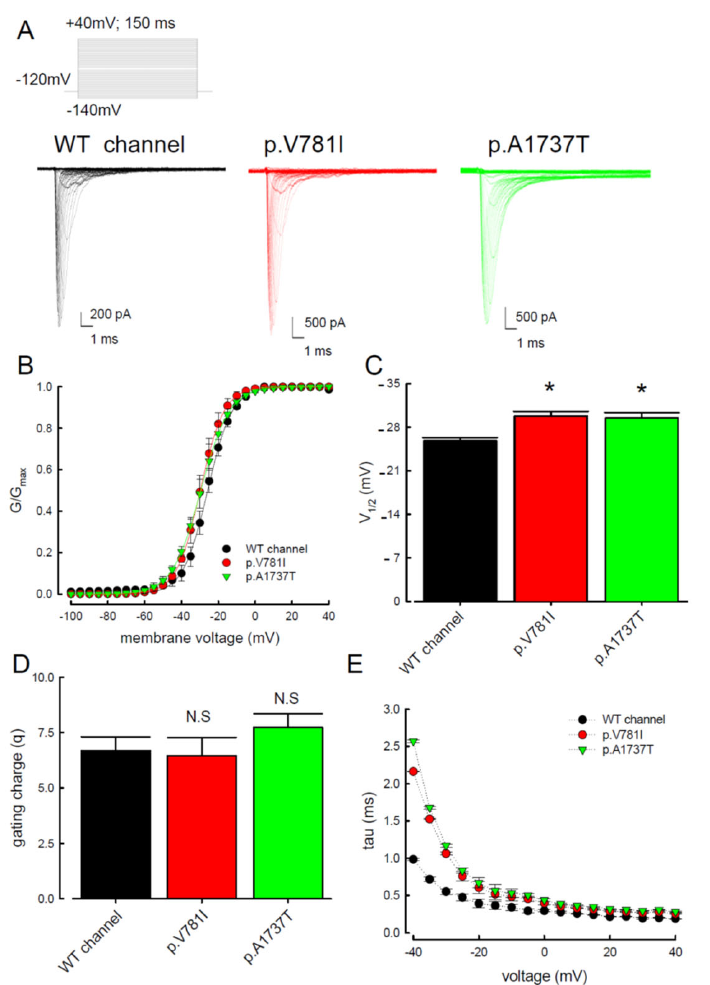
Figure 1. Analysis of the WT and the p.V781I and p.A1737T mutant sodium current activation process. ( A ) Cells voltage-clamped at − 120 mV were subjected to a series of 150 ms long pulses, sampled between − 140 and +40 mV in 5 mV increments. Sample sweeps from WT, p.V781I, and p.A1737T mutant Nav1.4 channels were recorded. ( B ) Sodium current activation curves (continuous lines) fitted to the data (symbols) by the Boltzmann function. Data are expressed as means and standard deviations ( n = 10). ( C ) The half-activation potential V 1/2 of these different channels was − 25.8 ± 0.2 mV, − 29.8 ± 0.6 mV, and − 29.5 ± 1.3 mV for the WT, p.V781I, and p.A1737T mutant channels, respectively. Data are expressed as means ± SEM ( n = 10; * p < 0.05 compared to control). ( D ) Note that the cumulative data displayed indicate that the slope ( k ) for the Na v 1.4 channel was associated with the WT, p.V781I, and p.A1737T mutant channels. Data are expressed as means ± SEM ( n = 10, N.S. = no statistically significant difference compared to control). ( E ) The fast inactivation time constants (tau) were obtained by fitting the decay phase of transient Na + currents of WT, p.V781I, and p.A1737T mutant channels shown in ( A ) with a mono ‐ exponential function. Data are expressed as means ± SEM.